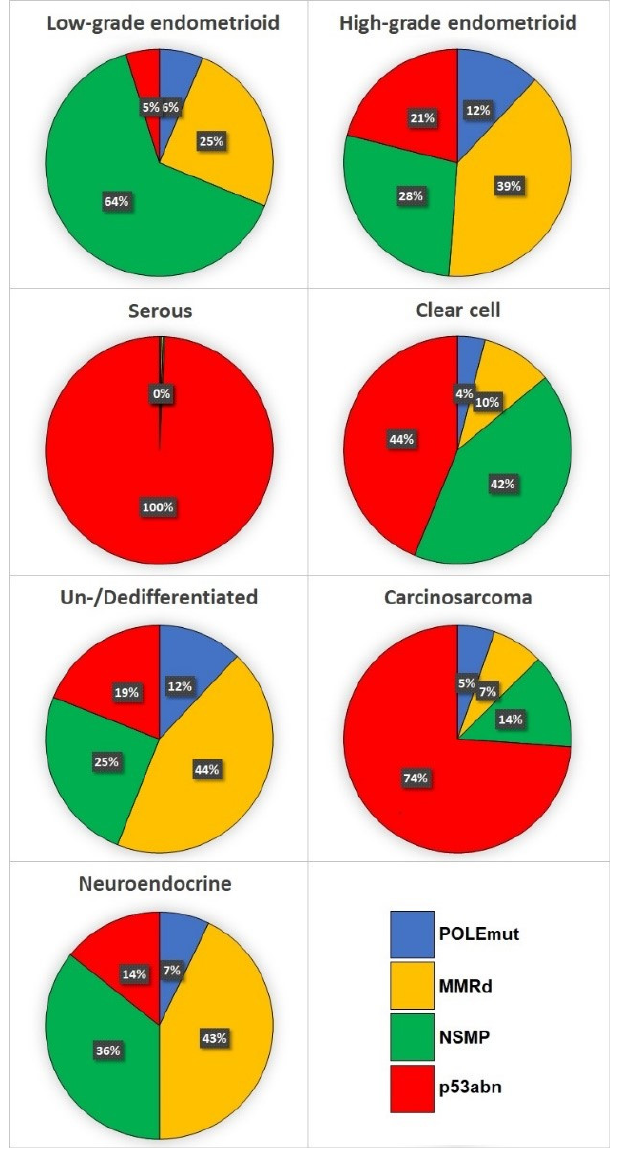
Figure 1. Distribution of TCGA molecular groups according to endometrial carcinoma histotype.